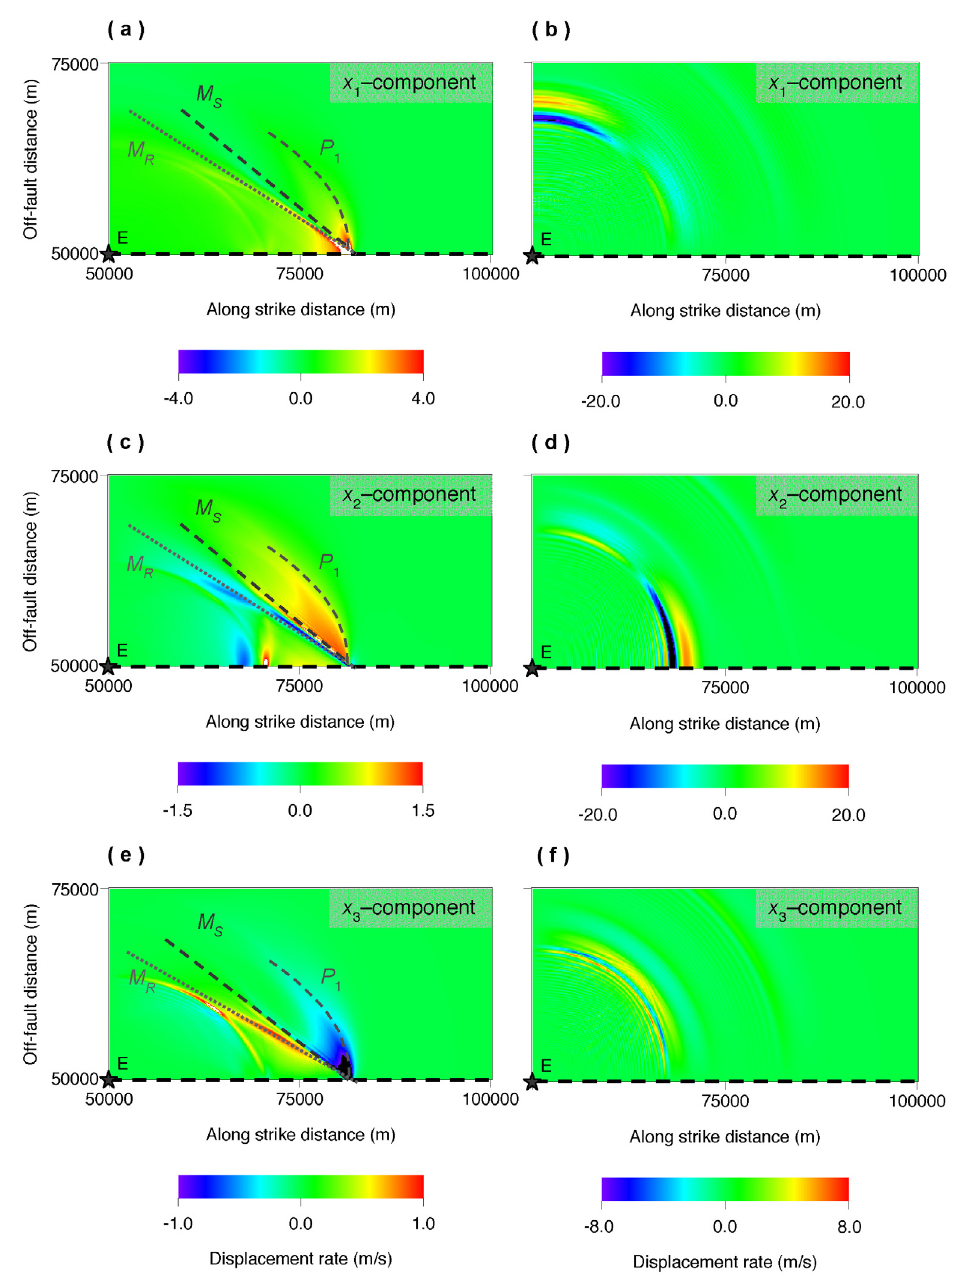
Figure 11. Comparison between the results from an extended fault model (left column) and those pertaining to a single point-source ap- proximation (right column). In the former case we assume that the spontaneous, supershear rupture, obeying the linear slip-weakening fric- tion law. In the latter case we assume a LA function. The parameters are those of Table 2 and the solutions are plotted at time t = 7 s from the nucleation. Due to the symmetry of the wavefields we only report the distribution on a quadrant of the computational domain. The fault trace ). (a) and (d) Fault-normal component ( V ). (e) and (f) Vertical com- is marked by a thick dashed line. (a) and (b) Fault-parallel component ( V 1 2 ). In the left panels P , M , M denote the first peak of particle velocity, the Rayleigh Mach and the shear Mach fronts, ponent ( V R S 3 1